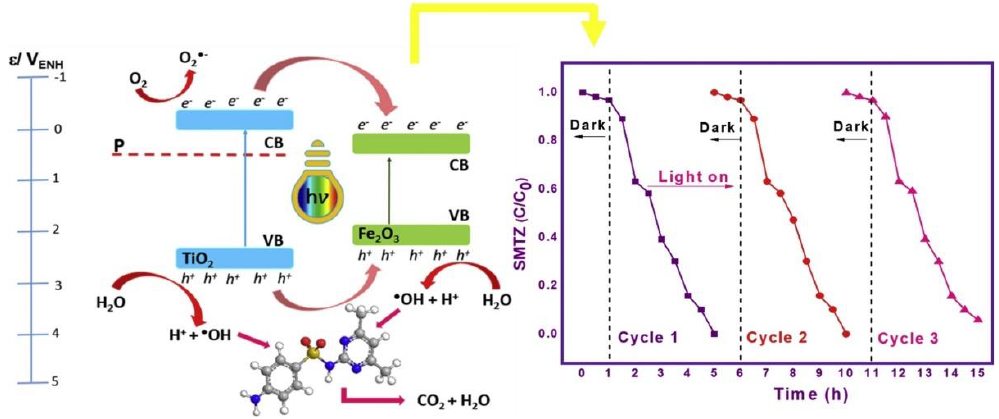
Figure 10. Photocatalytic mechanism of P-doped Fe 2 O 3 -TiO 2 against SMHZ [171]. Table 7. Summary of P/TiO 2 photocatalysts synthesized by variety of methods and source precur- sor materials.